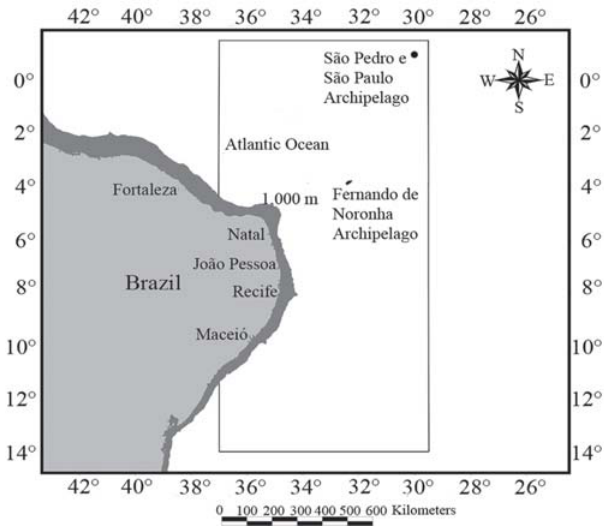
Fig. 1. Operational area (open rectangle) of commercial and research vessels of which T. obesus was